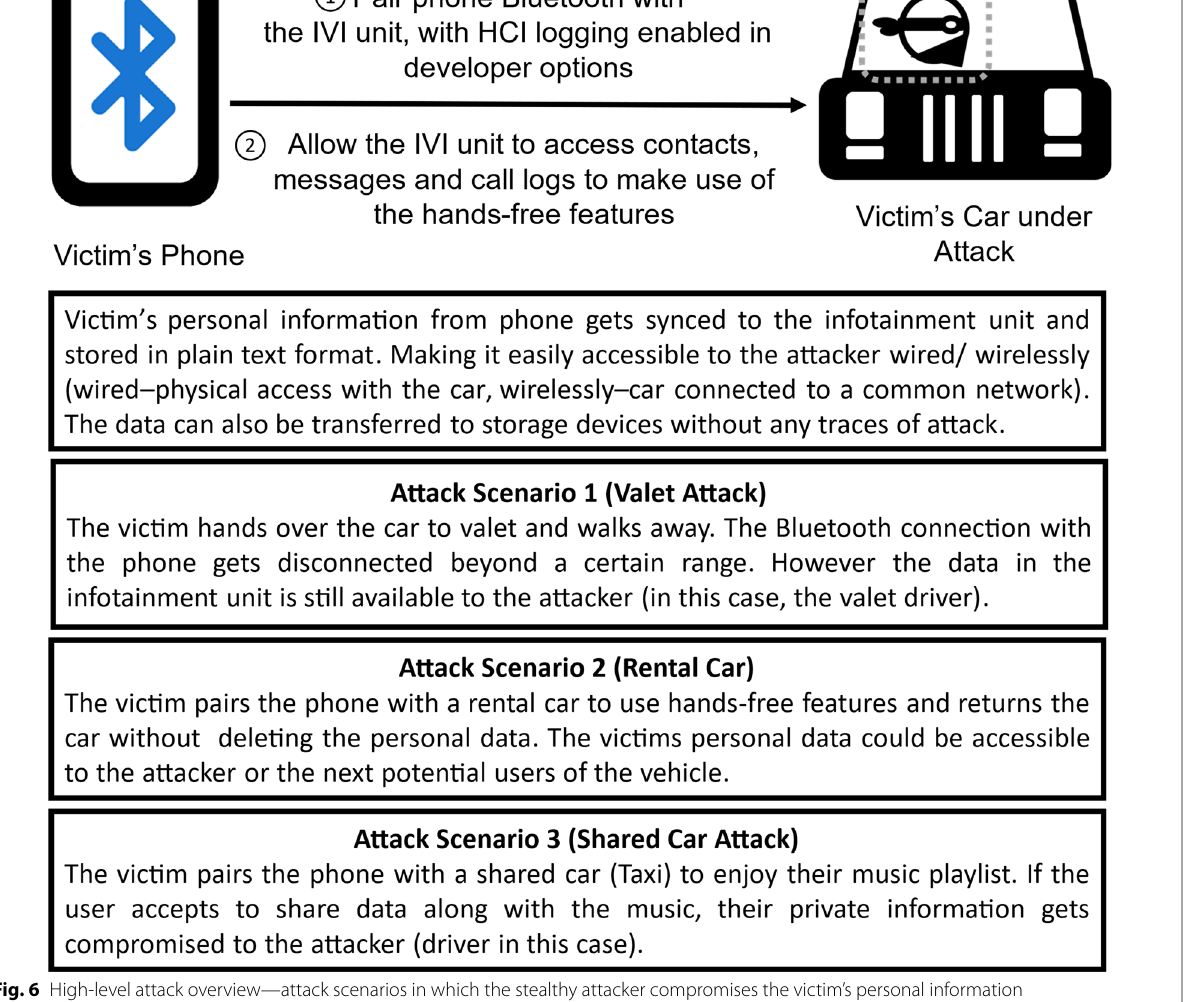
Fig. 6 High-level attack overview—attack scenarios in which the stealthy attacker compromises the victim’s personal